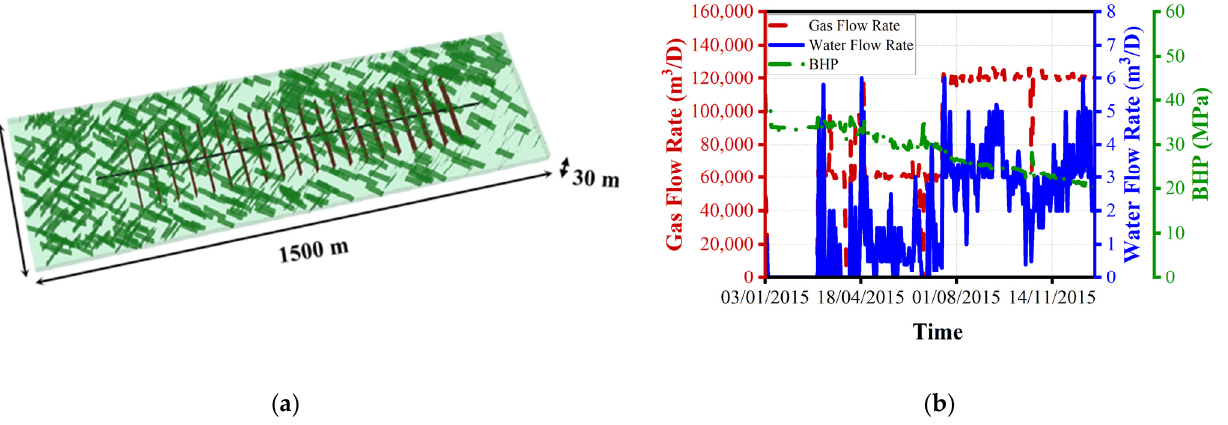
Figure 5. Schematic of the geometric model for numerical reservoir simulation and curves of the field data: ( a ) geometric model; ( b ) field data.